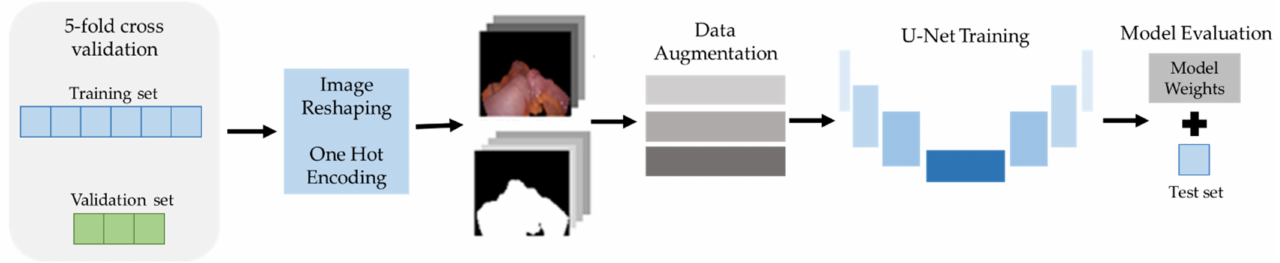
Figure 3. Scheme of the U-Net training and evaluation workflow considering a 5-fold cross-validation, image resampling, and a data augmentation strategy.